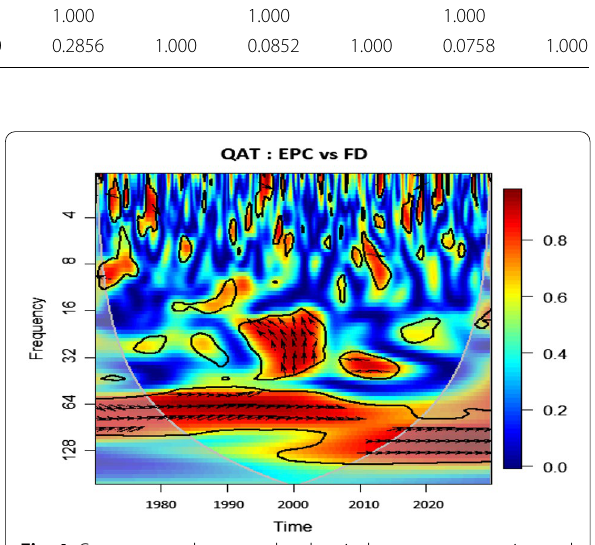
Fig. 4 Comovement between the electrical power consumption and financial development in Qatar